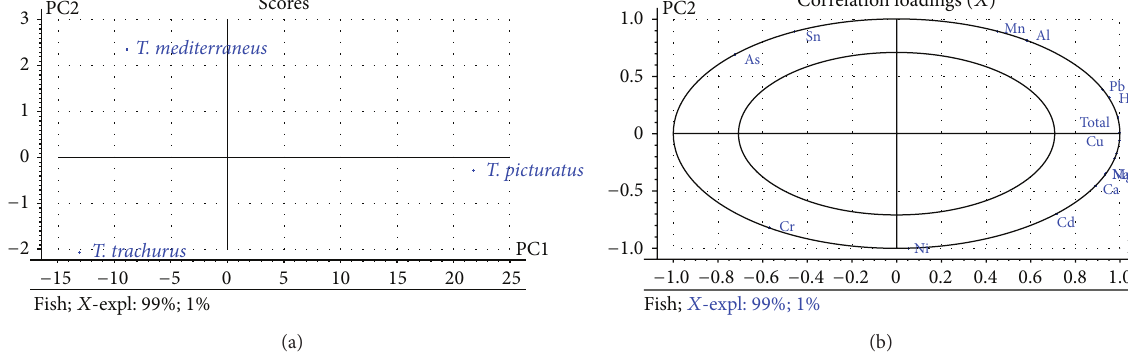
Figure 1: Score plot (a) and loading plot (b) of principal component analysis applied to the data